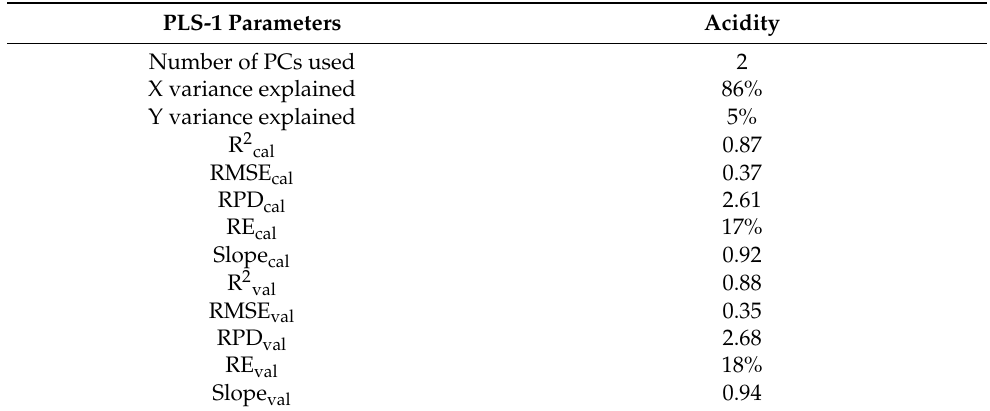
Table 2. Acidity partial least squares-1 (PLS-1) model results for the calibration (cal) and validation (val) sets. Total sample number: 50, with 35 and 15 for calibration and validation, respectively. X-matrix, EN signals; Y-matrix, acidity; PCs, principal components; R 2 , correlation; RMSE, root mean square error; RPD, ratio performance deviation; RE, relative error. PLS-1 Parameters Acidity Number of PCs used